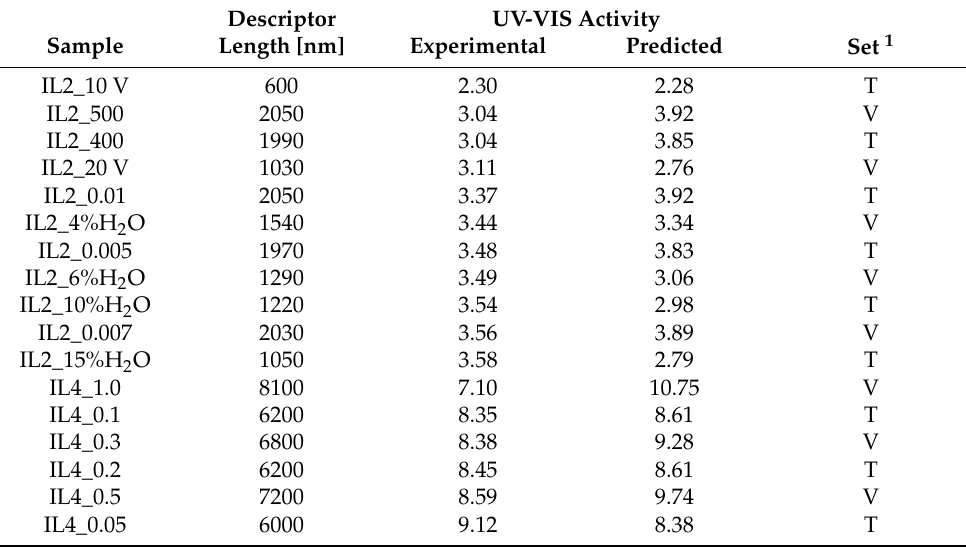
Table 2. Descriptors selected for the model and the modeled endpoint